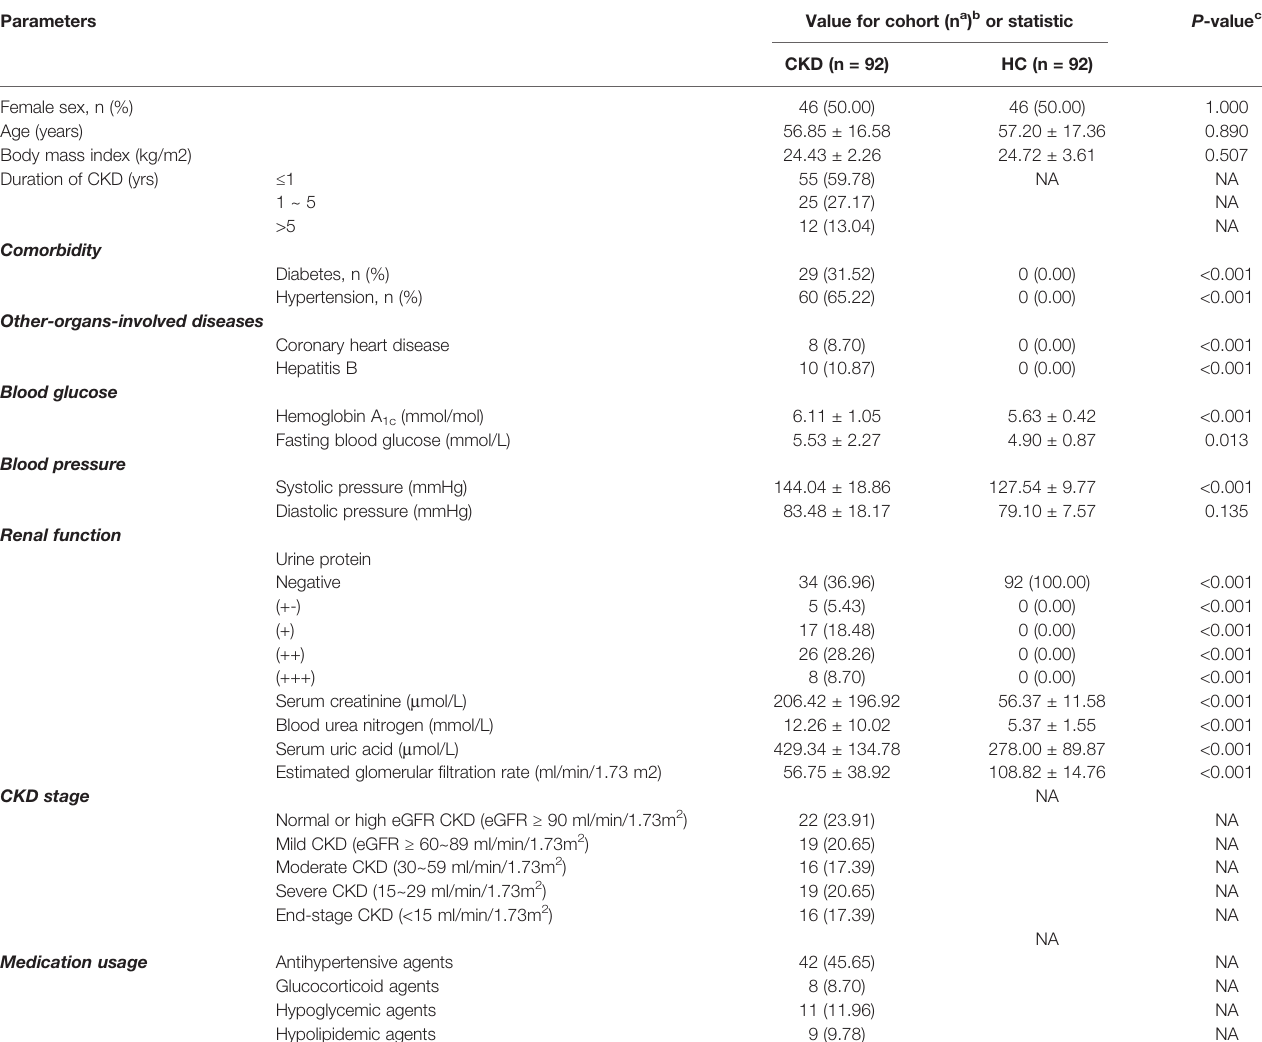
TABLE 1 | Characteristics of